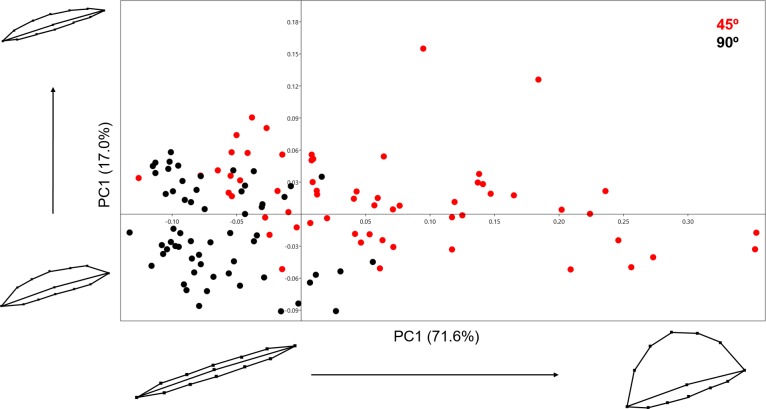
PCA graph presenting variance in cut mark form using the 13 landmark 3D model.Variance in form is presented for the extremities of both PC scores along their respected axis.